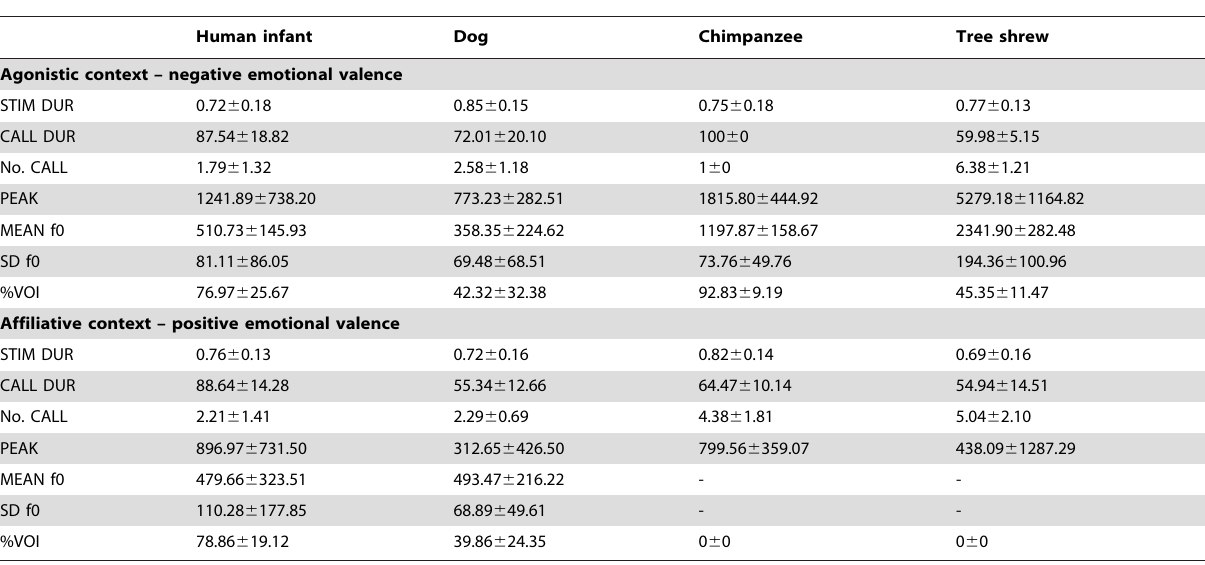
Table 2. Acoustic characterization of the playback categories.